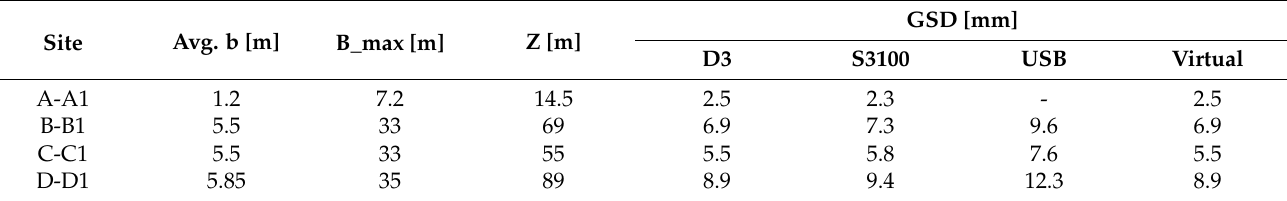
Table 3. Characteristics of the camera network and average GSD of the acquired